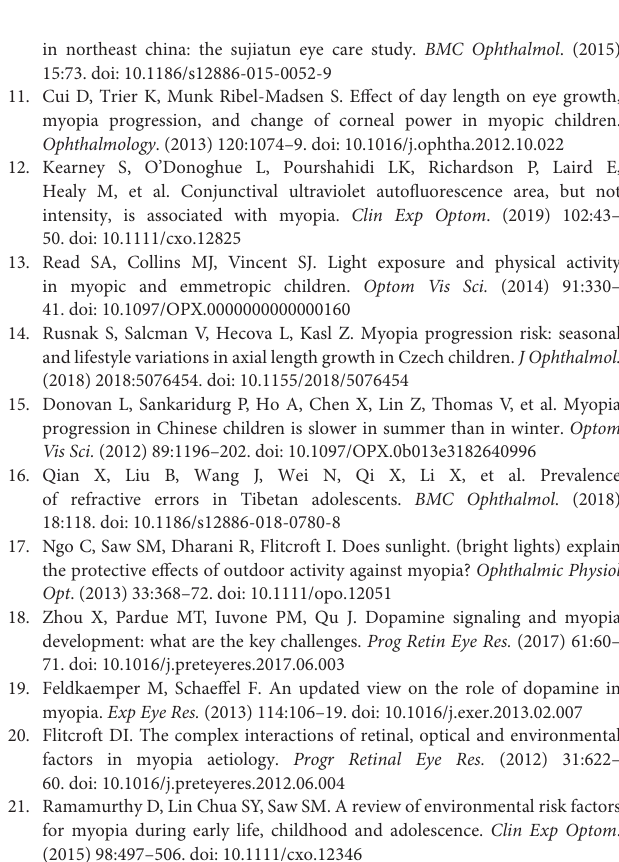
Supplementary Figure | The distribution of near vision time and outdoor time. (A) The distribution of near vision time in lowland area. (B) The distribution of near vision time in highland area. (C) The distribution of outdoor time in lowland area. (D) The distribution of outdoor time in highland